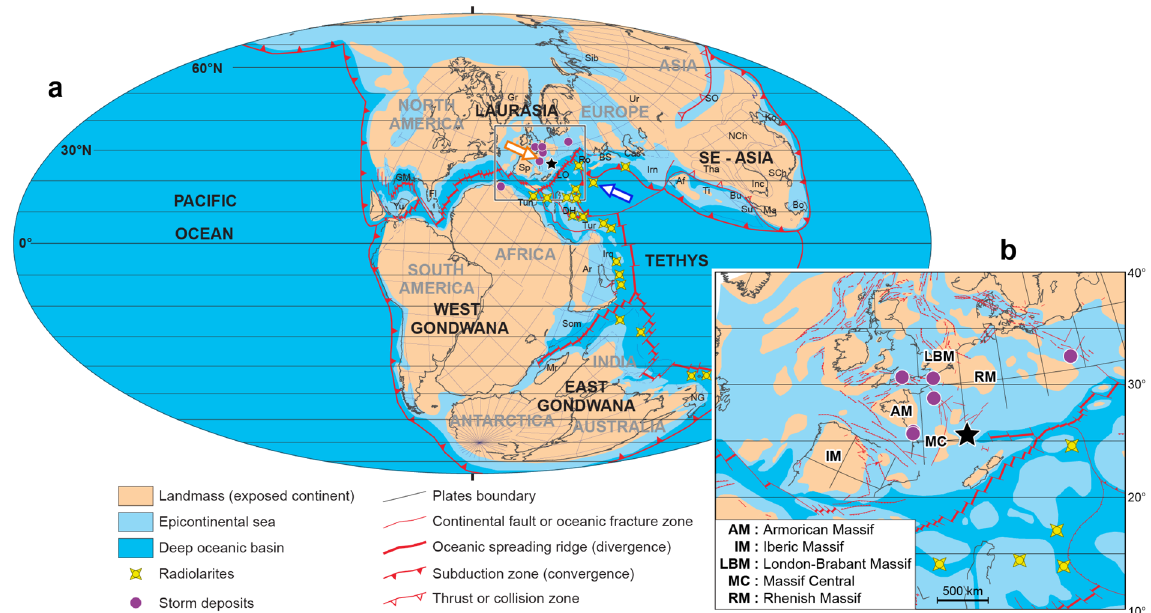
Figure 1. Late Jurassic (Kimmeridgian) paleogeographic Earth’s reconstruction. (a) Global map 85 . The Subalpine Basin is indicated by a black star. Potential paleomonsoon-like system showing atmospheric circulations in the Northwestern Tethyan Ocean. Northern Hemisphere summer (orange arrow) and winter (blue arrow). (b) A focus on the northwestern Tethyan realm (modified from Thierry 867581–84,87–90 ). Sites recording Kimmeridgian radiolarities are from Cecca et al. Sites recording Kimmeridgian storm deposits are compiled for the present